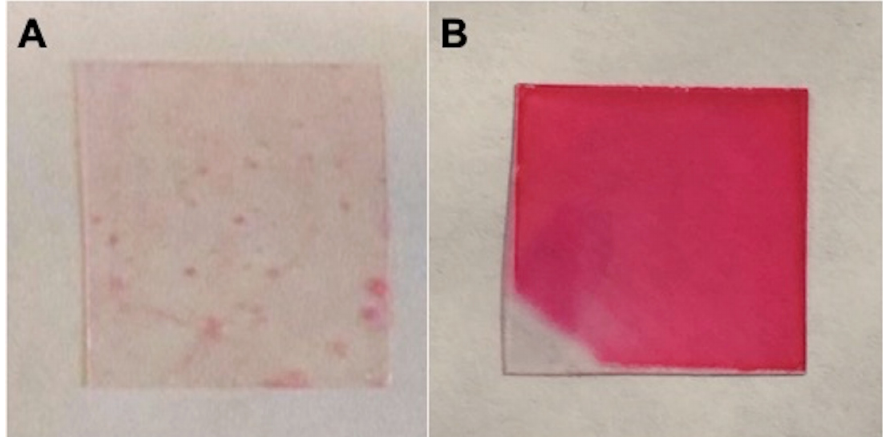
Figure 1. ( A ) Photograph of film that was exposed to the vapors from the sol while aging. Sparse aggregates loaded with rhodamine 6G (R6G) could be seen on the film. ( B ) Photograph of film that was not exposed to vapors while aging. The continuous film loaded with R6G, except the corner that was not dipped into the sol during coating, could be seen.